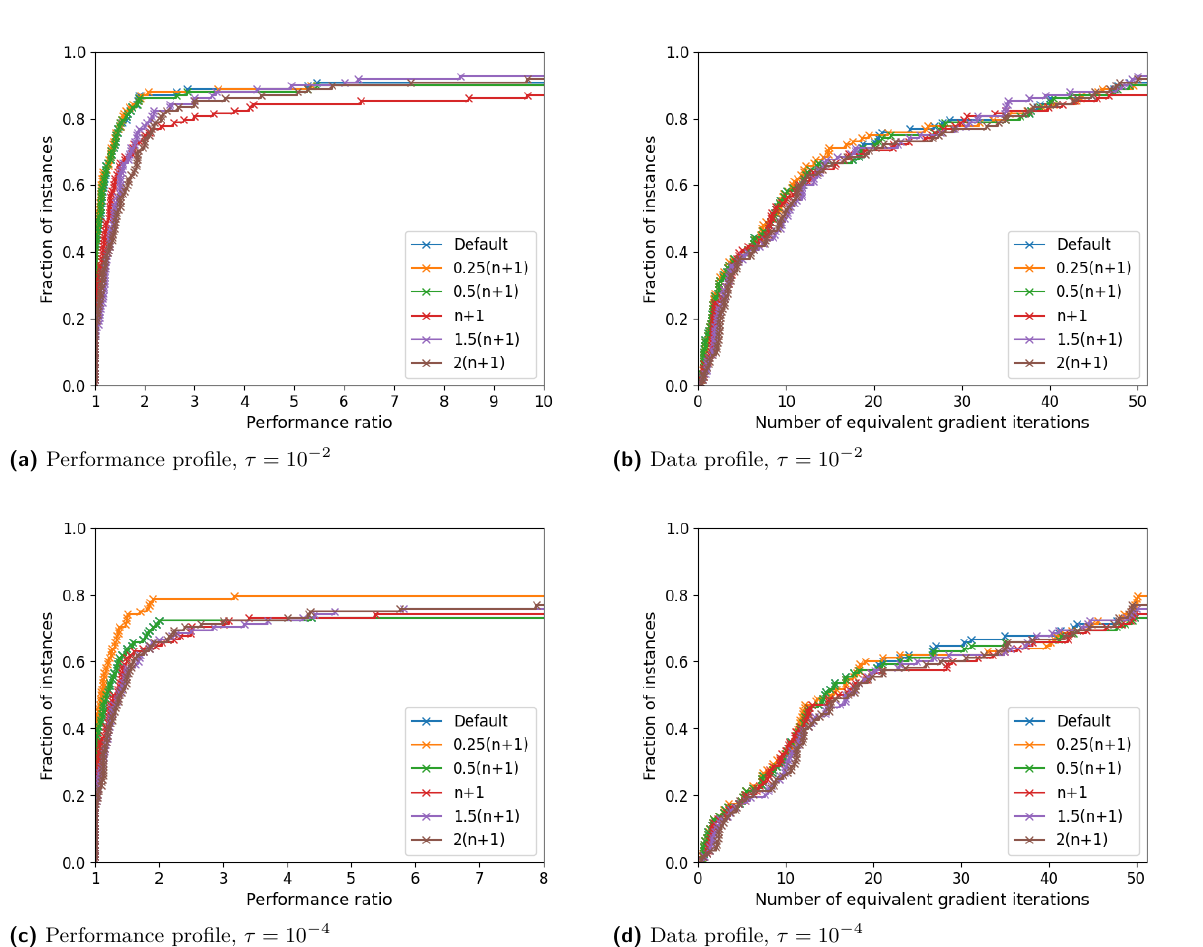
Figure 2 Performance profiles (left) and data profiles (right) using a different number of sample points in the initialization